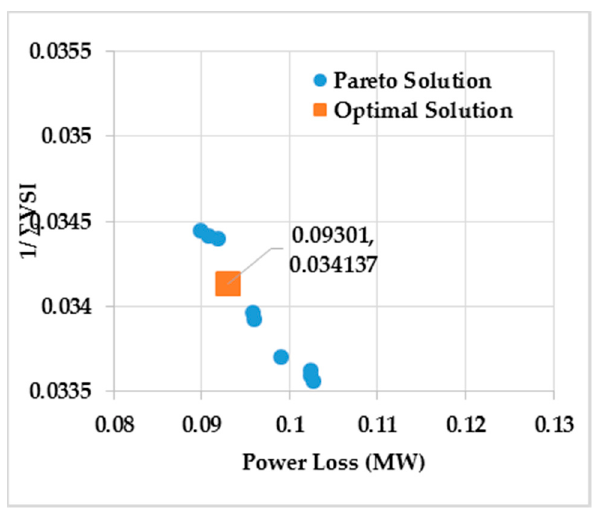
Figure 14. Pareto-solution and optimal compromise solution for Type-1 (2 DG).